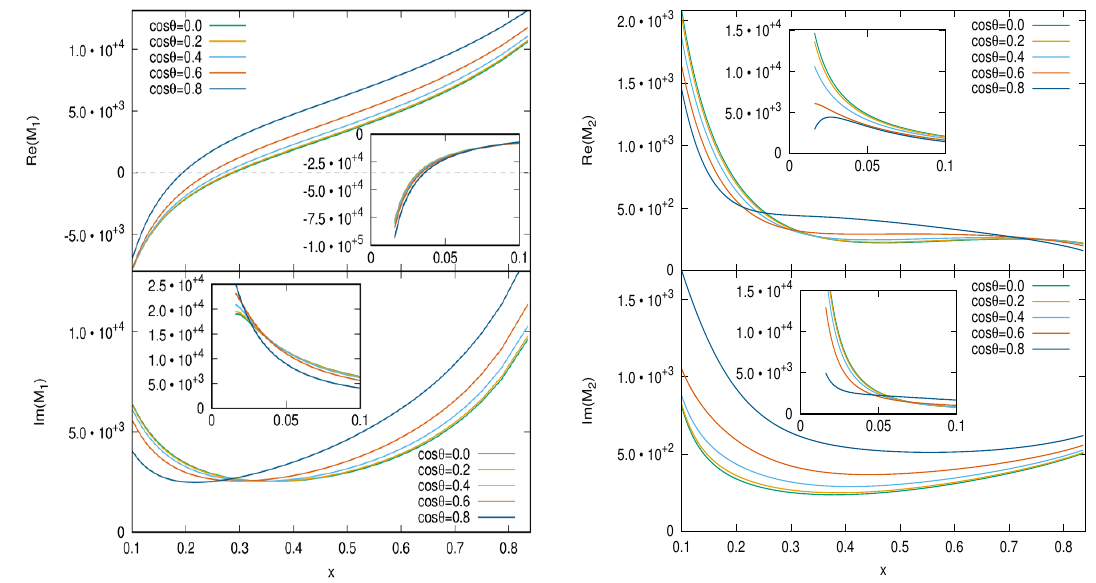
Figure 3 . Behavior of M B; (2) ; (cid:12)n (left) and M B; (2) ; (cid:12)n (right) as a function of the scaling variable 1 2 x for di(cid:11)erent values of cos( (cid:18) ). The insets show the region close to x = 0.